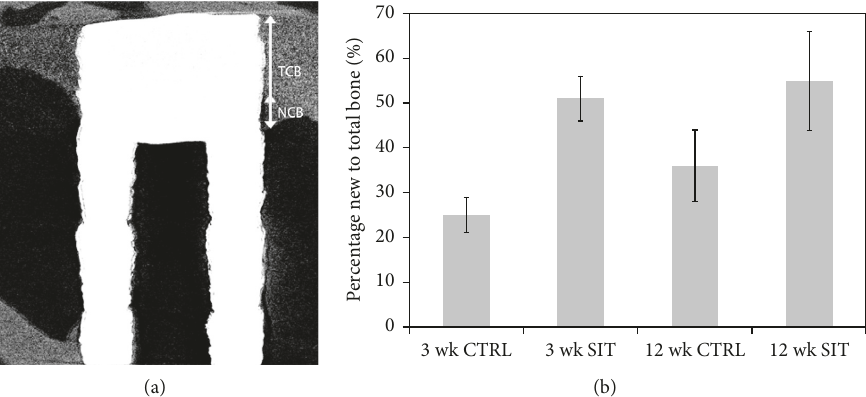
Figure 7: (a) Representative micro-CT orthoslice of the SIT device, indicating new cortical bone growth (NCB) and total cortical bone (TCB) from the coronal surface after implantation. (b) Graphical comparison of new bone formation under the cortical bone crest to total bone crest height observed after 3- and 12-week implantation for control and SIT